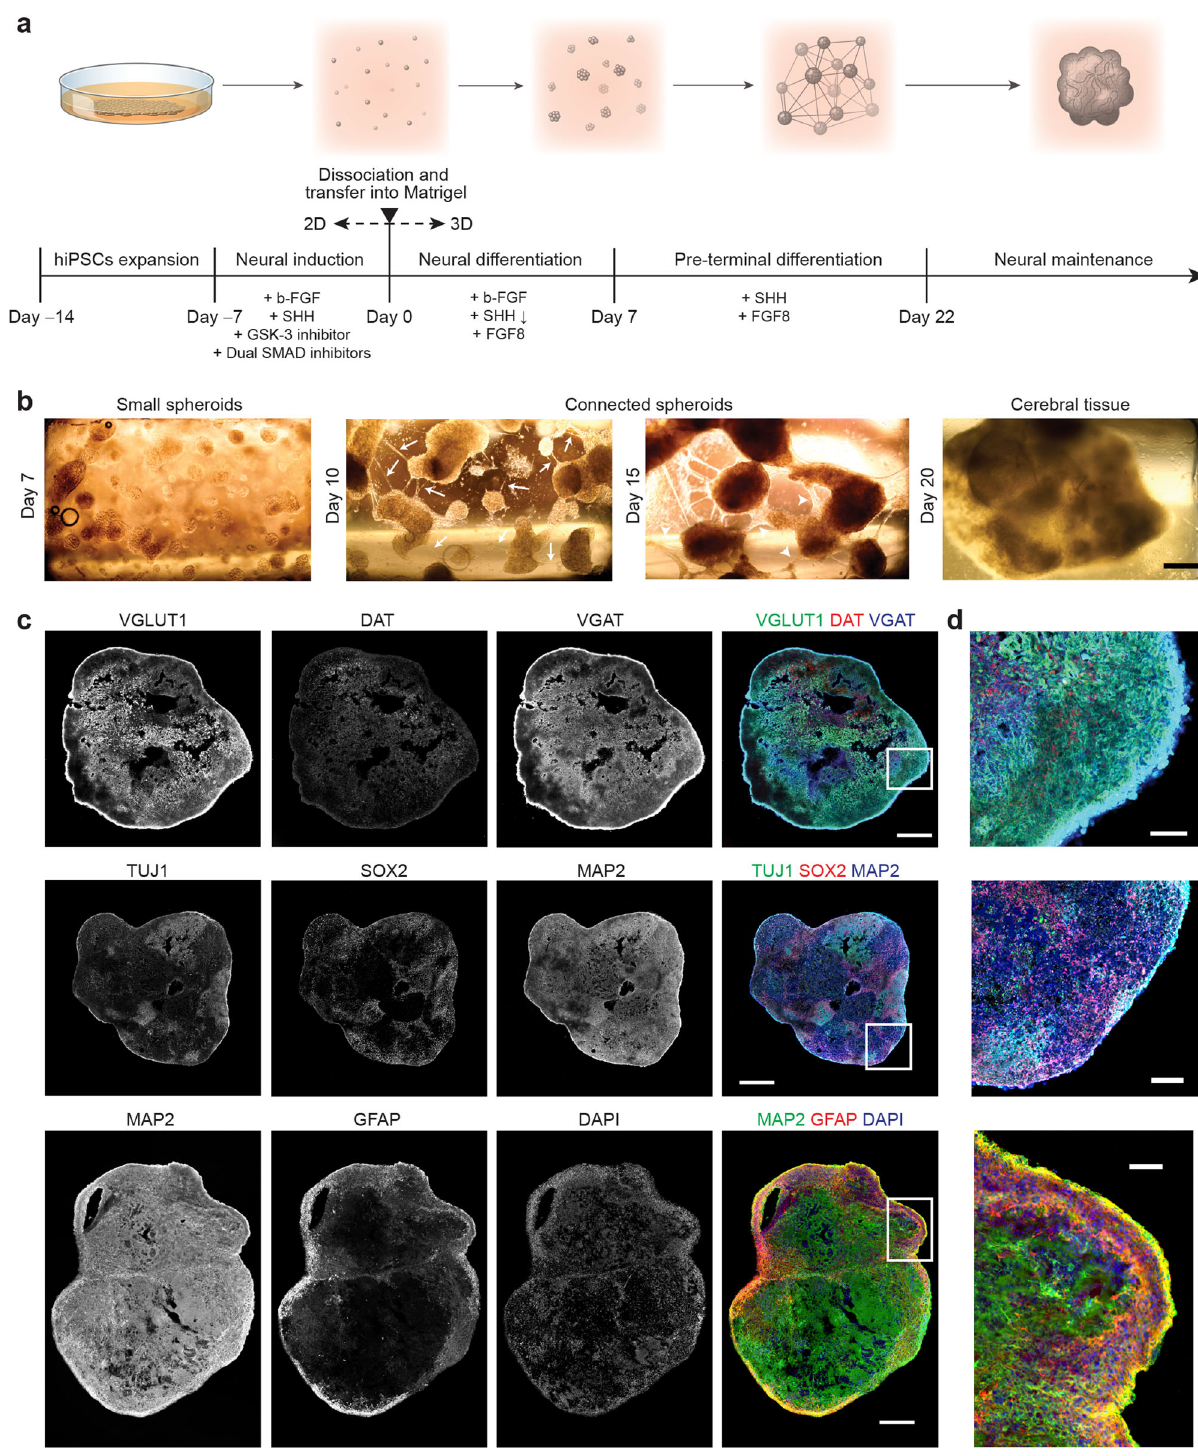
Fig. 1 Formation of human cerebral tissues via matrix-supported active reaggregation of cells (MARC). a Schematics of the MARC culture method, showing the different culture steps. Timeline and additives supplied in each step are indicated. b Example phase-contrast images at the different 3D-culture phases, showing the matrix-supported active reaggregation of the cells into cerebral tissues. Single dissociated cells suspended in Matrigel grew into small spheroids (Day 1 – 7). During pre-terminal differentiation, neurite outgrowths extended from the spheroids (white arrows), and merged into neurite bundles (white arrowheads) between spheroids (Day 10, 15). The spheroids migrated and subsequently merged into large cerebral tissues (Day 20) ( n = 120 samples across six independent experiments). Scale bar: 500 µ m. c Immunohistochemical co-staining of cryosections of MARC-produced cerebral tissues at Day 90 revealed the presence of markers of neural progenitor cells (NPCs; SOX2), early and mature neurons (Tuj1 and MAP2), mature excitatory Glutamatergic neurons (VGLUT1), inhibitory GABAergic neurons (VGAT), mature dopaminergic neurons (DAT), and astrocytes (GFAP), indicating the cellular diversity of the MARC-produced cerebral tissues ( n = 5 samples across two independent experiments). Scale bar: 500 µ m. d Zoom- ins of the images in c as indicated by the white squares. Scale bar: 100 µ m. COMMUNICATIONS BIOLOGY| (2022) 5:254